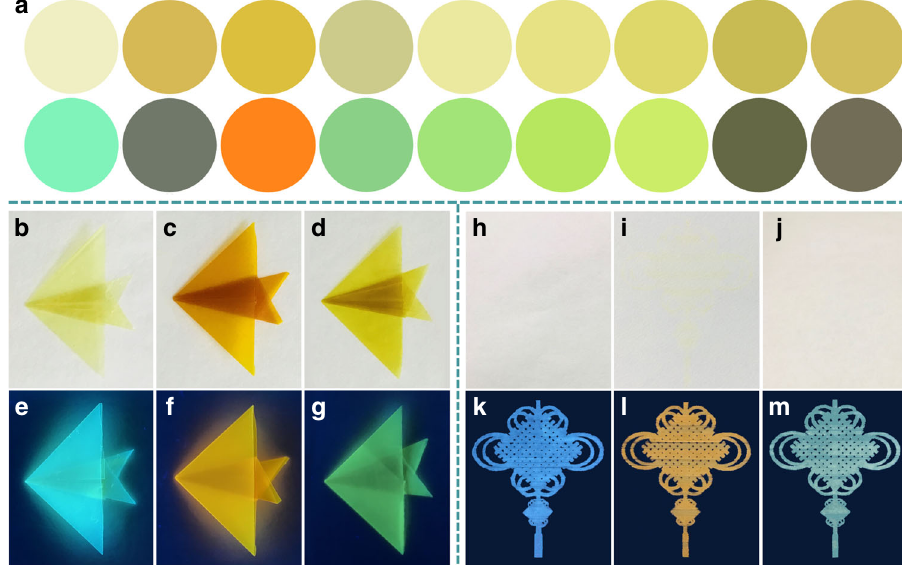
Fig. 8 Versatile fl uorescent materials. a Visual (top) and fl uorescence colors (bottom) of metallacycles H1 – H9 -coated TLC plates (Figures showed from left to right were sequentially corresponded to metallacycles H1 – H9 ). The fl uorescence colors were observed by using a hand-held UV lamp with an excitation at 365 nm. Photographs of the fl exible fl uorescent fi lms b – g and the fl uorescent patterns h – m by inkjet printing from metallacycle H1 in visible light b , h and under 365 nm light excitation e , k , metallacycle H3 in visible light c , i and under 365 nm light excitation f , l , metallacycle H7 in visible light d , j and under 365 nm light excitation g ,